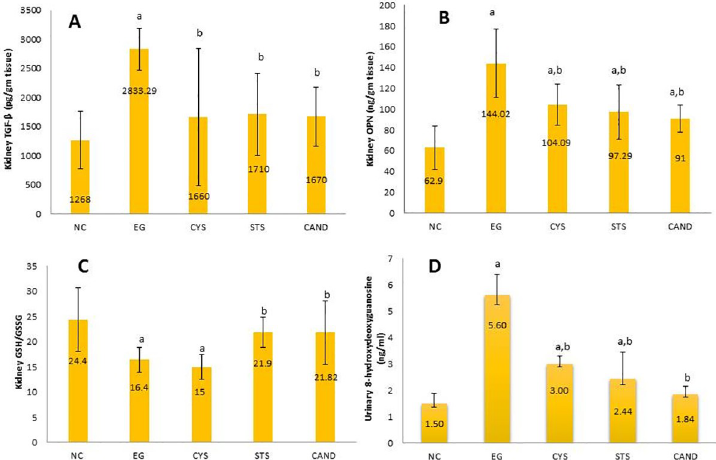
Fig 3. Effect of CYS, STS, CAND treatments on: (A) Renal transforming growth factor-beta (TGF- β ) (B) Renal osteopontin (OPN) (C) renal oxidative stress parameter GSH/GSSG (D) Urinary oxidative stress biomarker (8-OHdG). Data are represented as a mean ± SD (n = 20/group), significance was set at p < 0.05; a: Significant vs NC group, b: Significant vs EG control group. NC group: Rats received water; EG group: (1% ethylene glycol in drinking water for 28 days); CYS group: (EG + 750 mg/kg CYS, orally, once daily); STS group: (EG + 0.4 g/kg STS, i.p., 3 times/ week); CAND group: (EG + 70 μ g/mL CAND in drinking water). Treatments were administered simultaneously with EG drinking water for 28